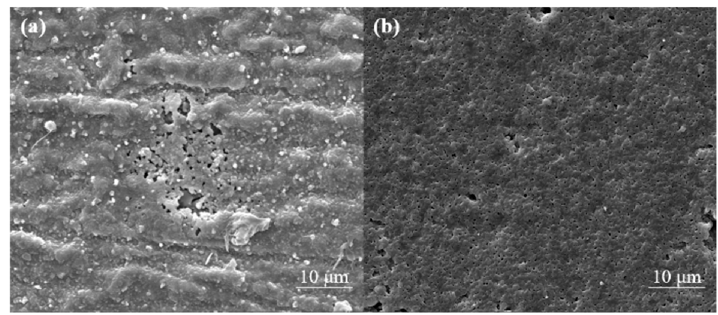
Figure 4. The micromorphology observed by SEM: ( a ) blank plate and ( b ) coated plate.